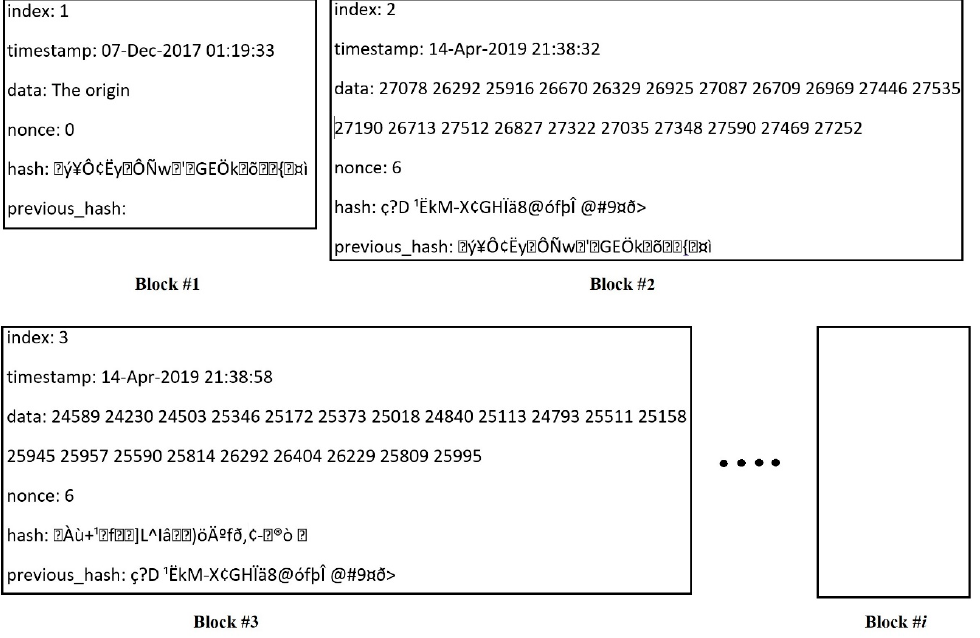
Figure 8. The proposed scheme latency test. 6. Conclusion The main aim of this study was to provide a state-of-the-art solution for managing different biomedical data types in a scheme that improves data integrity and makes the working system more